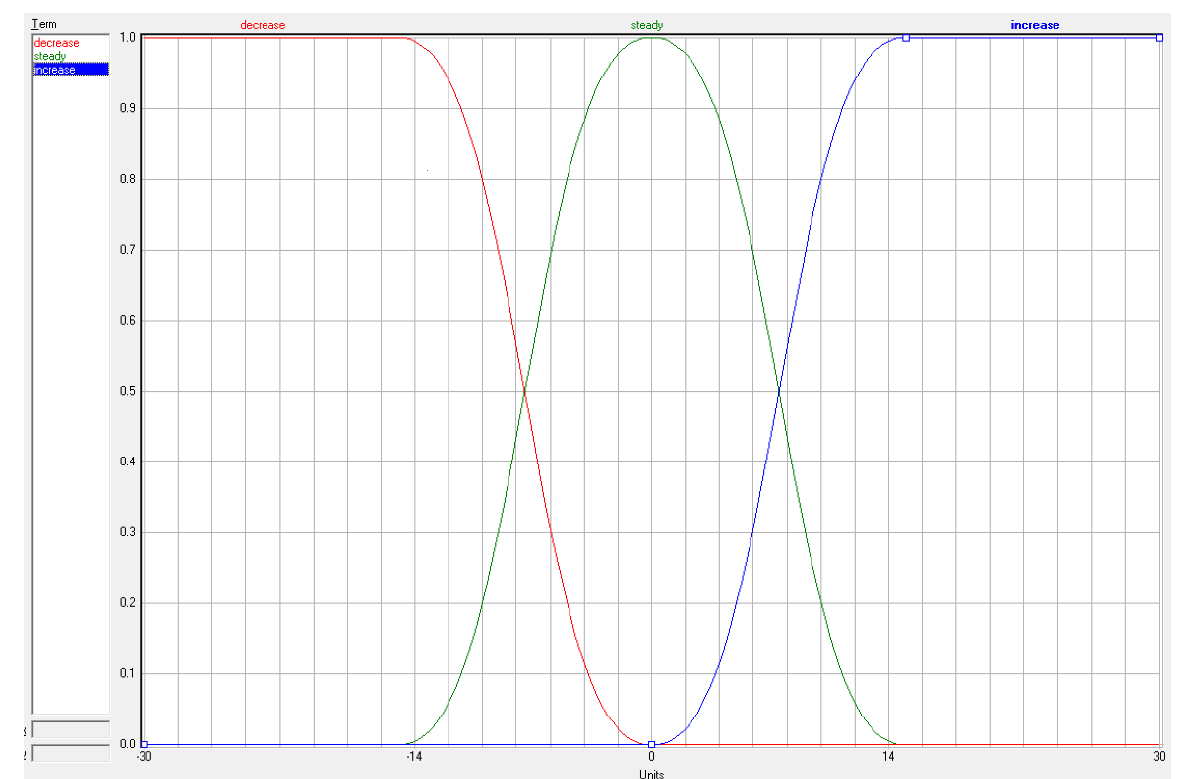
Figure 4. Defined membership functions for the variable “output” representing the forecast of the trends in the volume of nonperforming loans. Source: based on the author’s own studies.